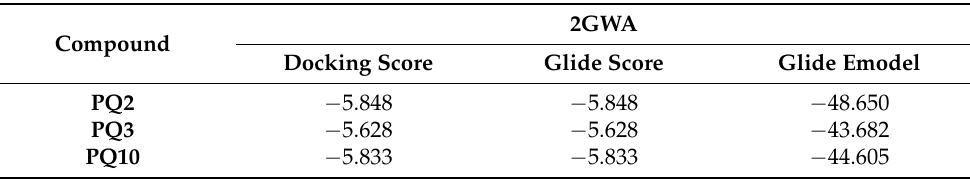
Table 3. Docking score (kcal/mol), glide gscore (kcal/mol) and glide emodel (kcal/mol) results of PQ2 , PQ3 , and PQ10 for DNA (PDB ID: